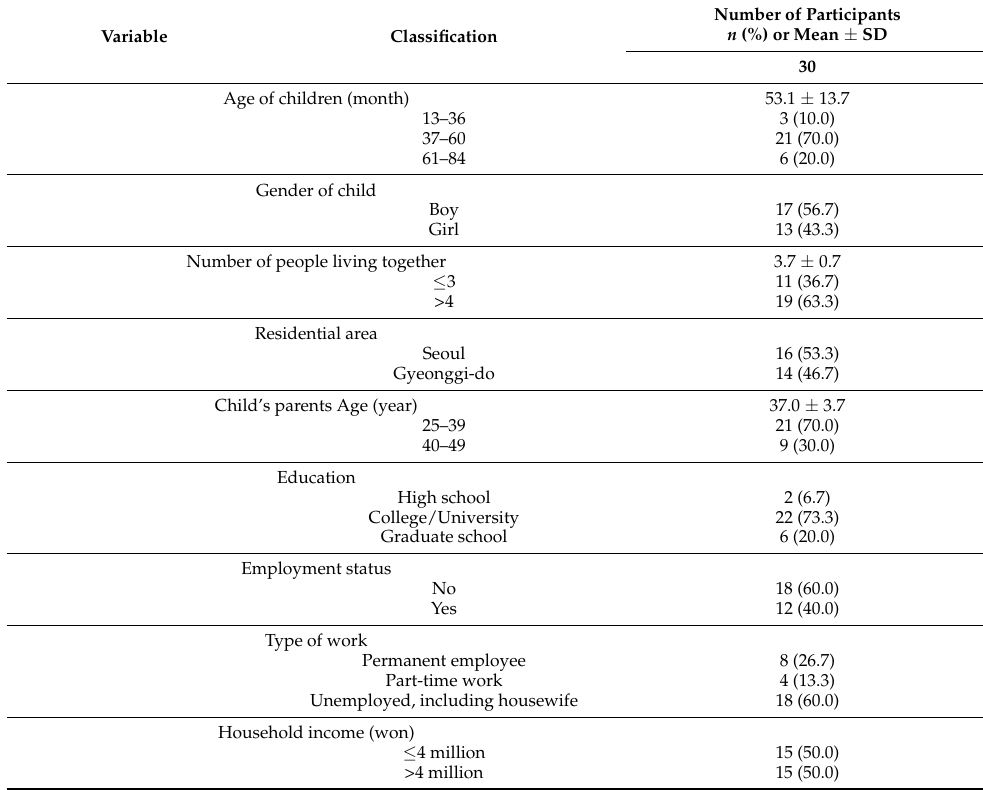
Table 1. General characteristics of the participants and their